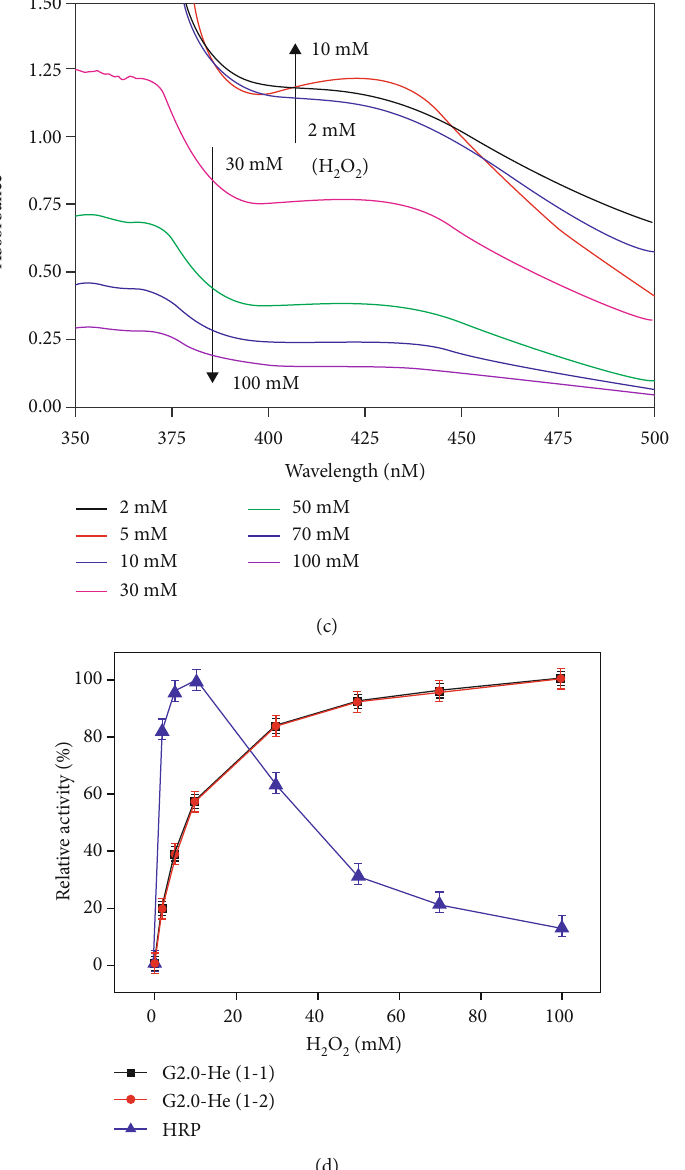
Figure 5: The absorbance of G2.0-He (1-1) (a), G2.0-He (1-2) (b), and HRP (c) and the relative activity of G2.0-He (1-1) and (1-2) and HRP (d) for the pyrogallol oxidation reactions with the H